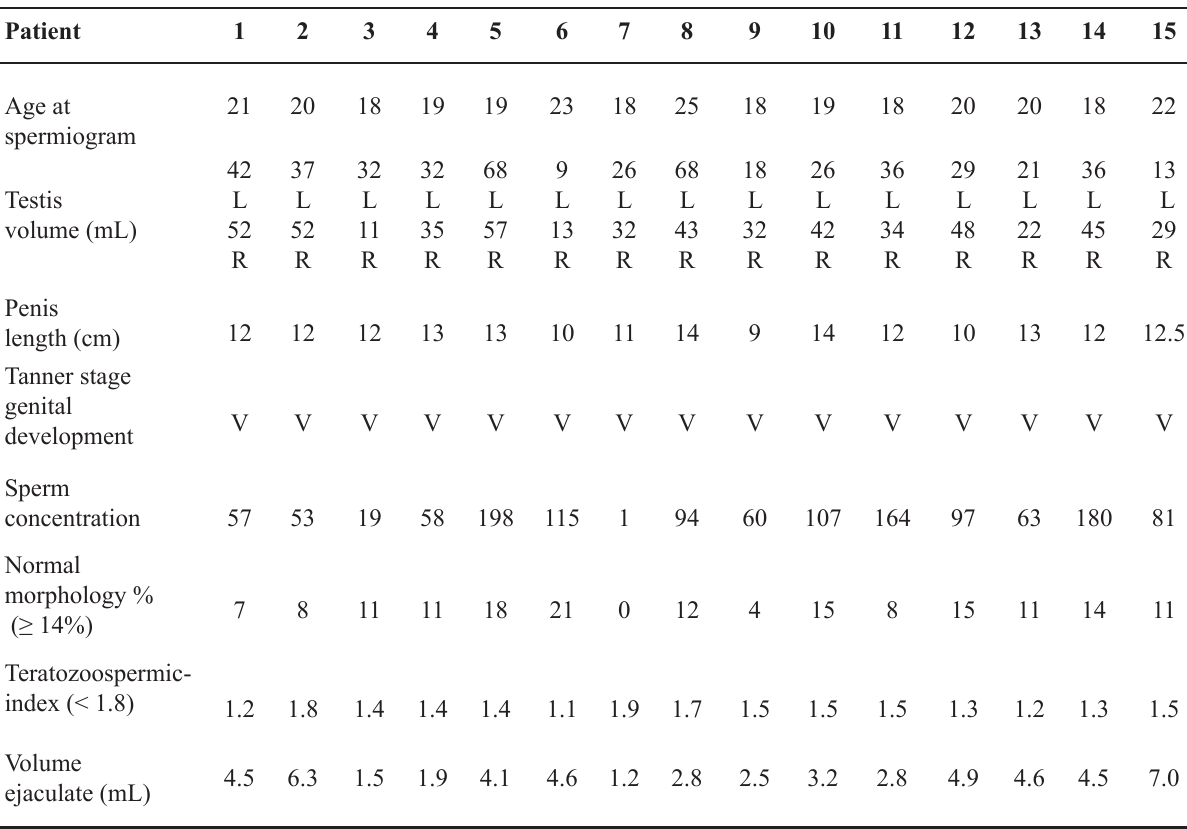
Table 2 – Characteristics of the 15 patients with cryptorchidism initially treated with surgery and luteinizing hormone releasing hormone, at follow-up after